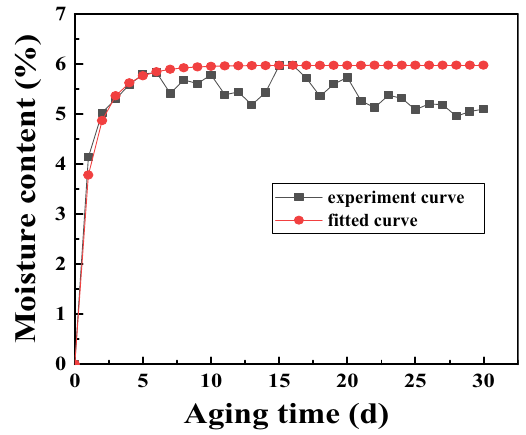
Figure 6: Moisture absorption ratio versus aging time curve based on the experimental results and the modi fi ed Fickian